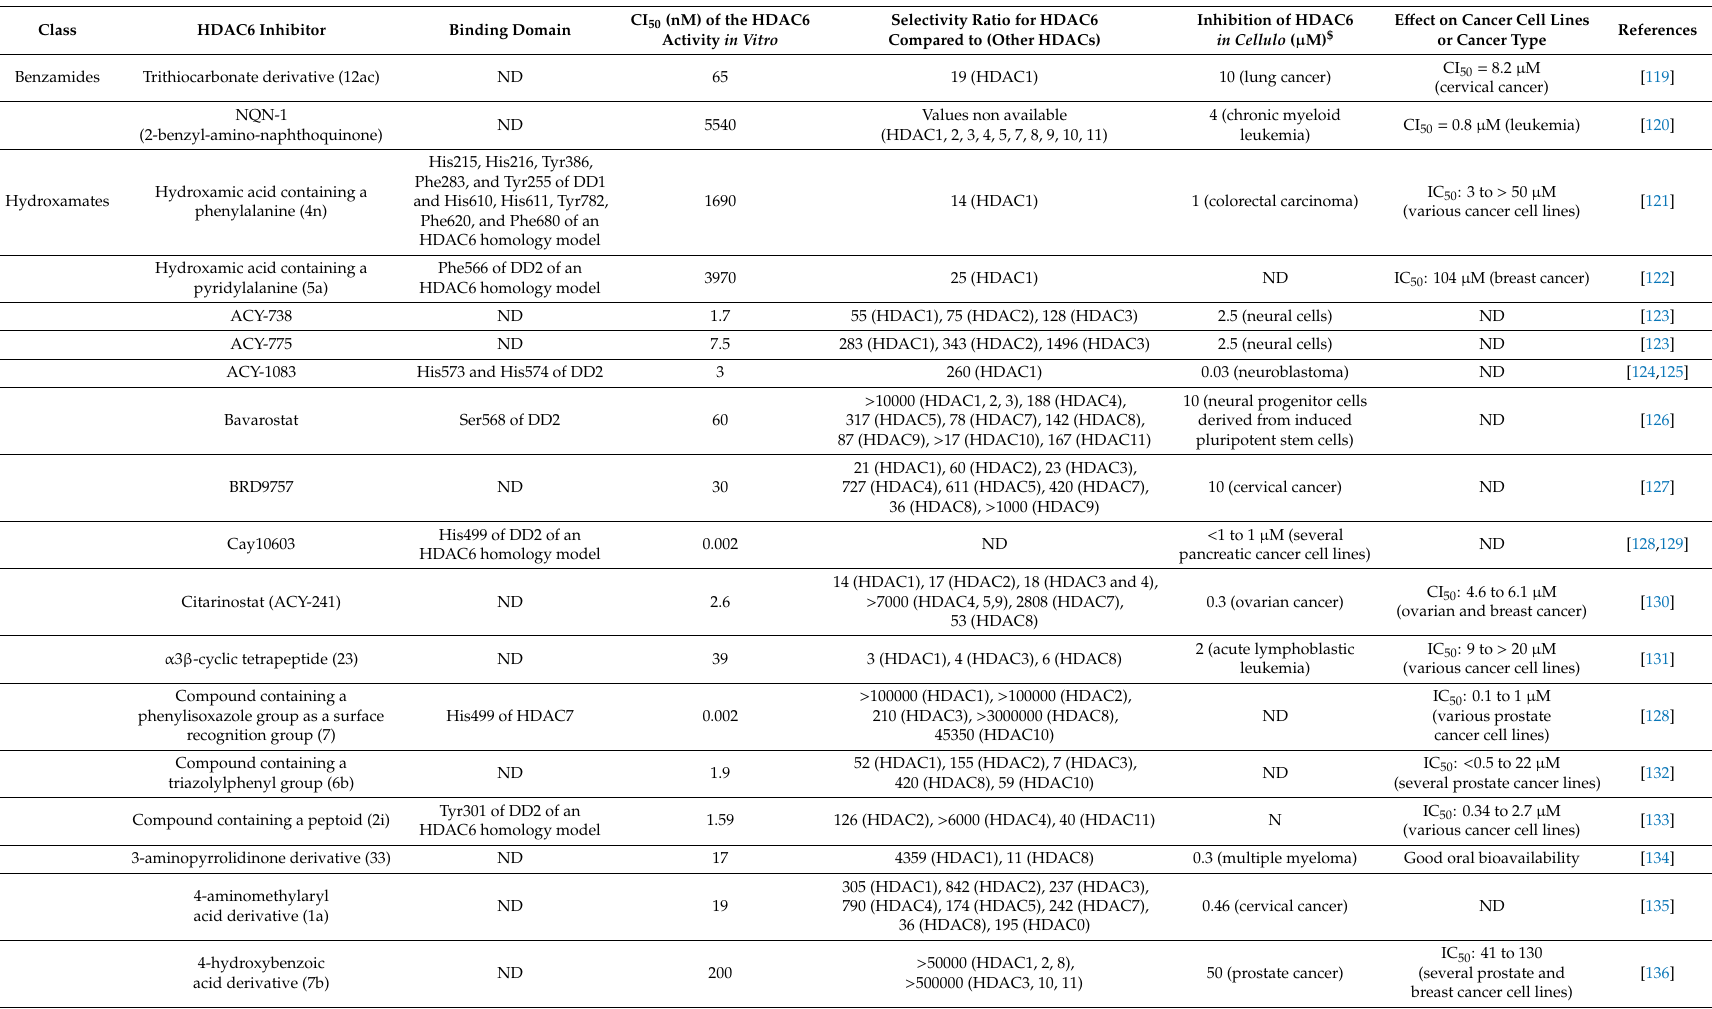
Table 8. List of HDAC6